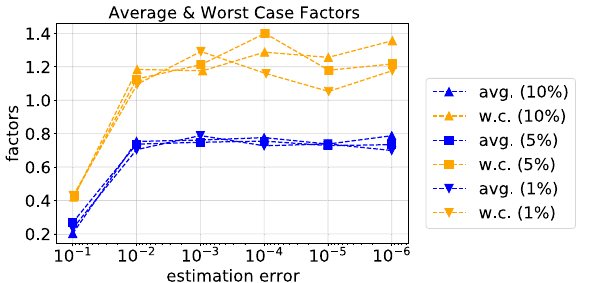
Fig. 6 K -schedule. Average, standard deviation, minimum, and maximum value of K i + 1 / K i per iteration over 1000 repetitions of